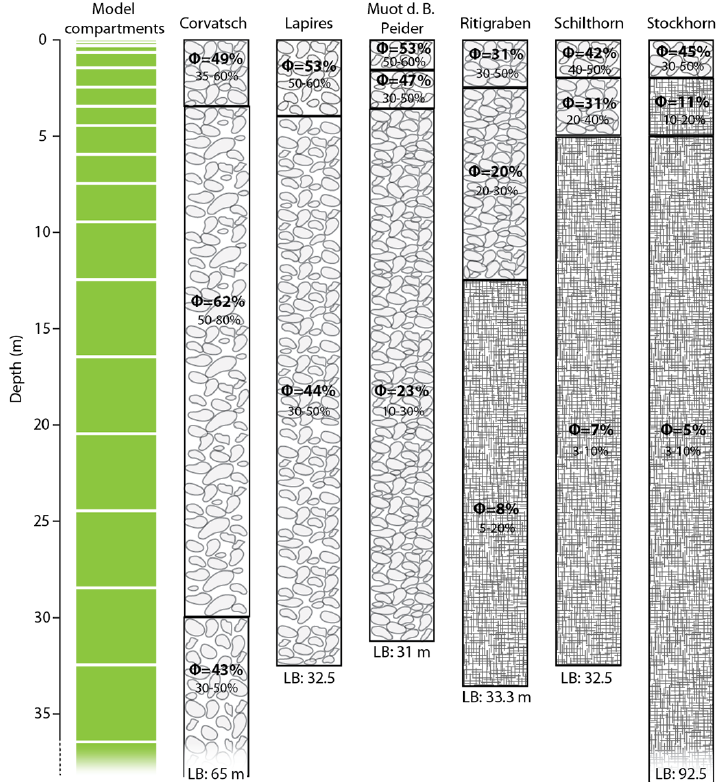
Figure 3. Description of the model layers as defined in the model (green) and of the simulated subsurface structure for each site. The depths of the horizons were estimated by experts, based on data from boreholes and geophysical surveys, whereas the porosity (cid:56) is defined by the GLUE calibration based on the ranges estimated by the experts (given below the GLUE estimated porosity values). The maximum depth for each site (lower boundary, LB) is given below each